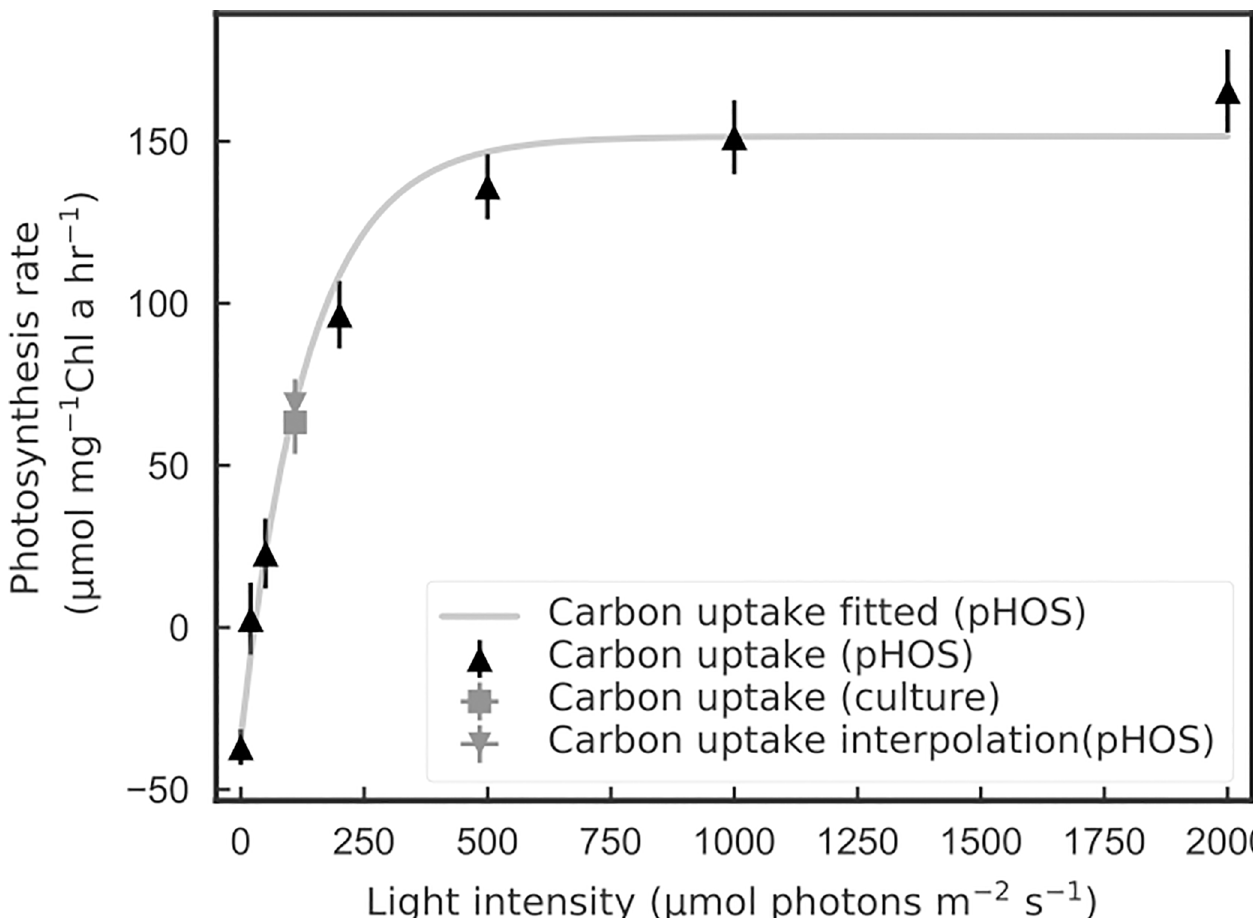
Fig 5. Carbon uptake rates vs. irradiance (n = 3) using pHOS. The estimated net carbon growth rate for a separate culture validation experiment at 110 μmole quanta m -2 s -1 is indicated by the closed square and the corresponding interpolation from the pHOS data at the same irradiance is shown in the inverted triangle (n = 6). Carbon uptake rates determined from these two approaches are not significantly different from each other (p > 0.05).